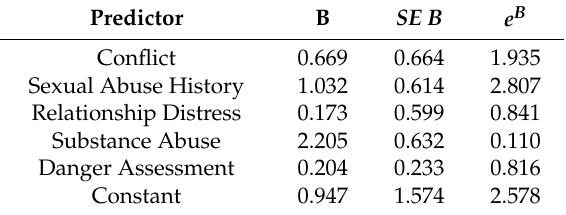
Table 2. Summary of Logistic Regression Analyses in model including victim